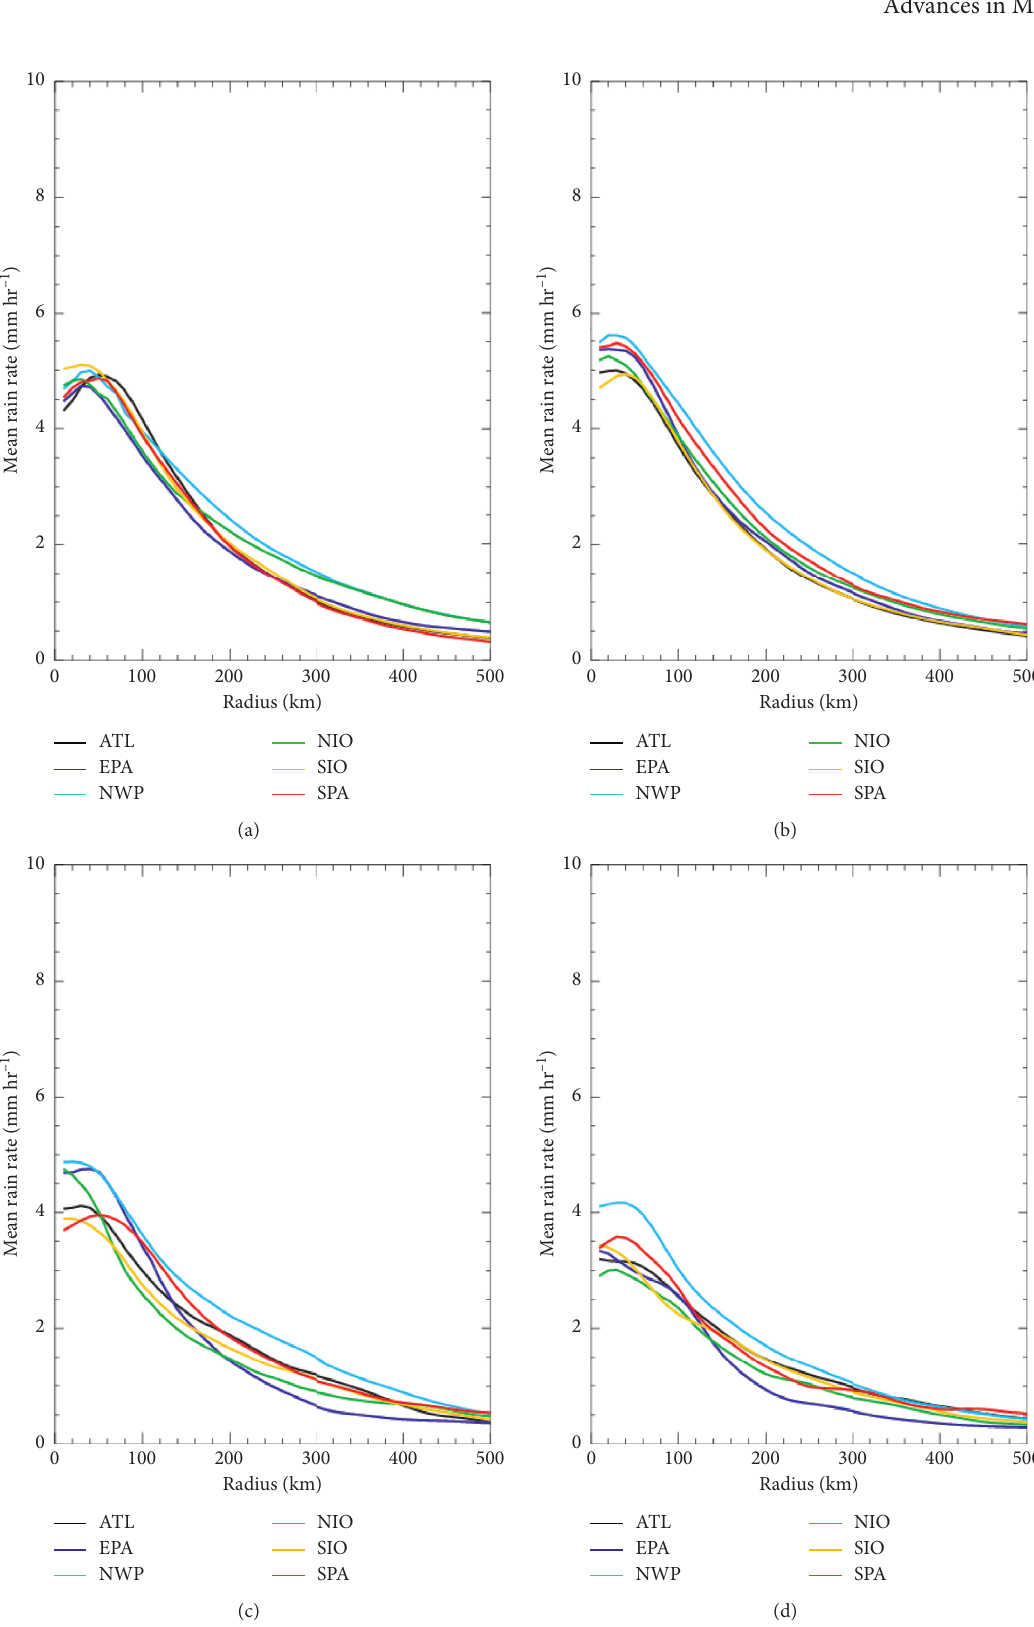
Figure 1: Mean rain rates for (a) off-shore, (b) preland, and (c) in-land under high-PV environmental condition and (d) in-land under low- PV condition over different